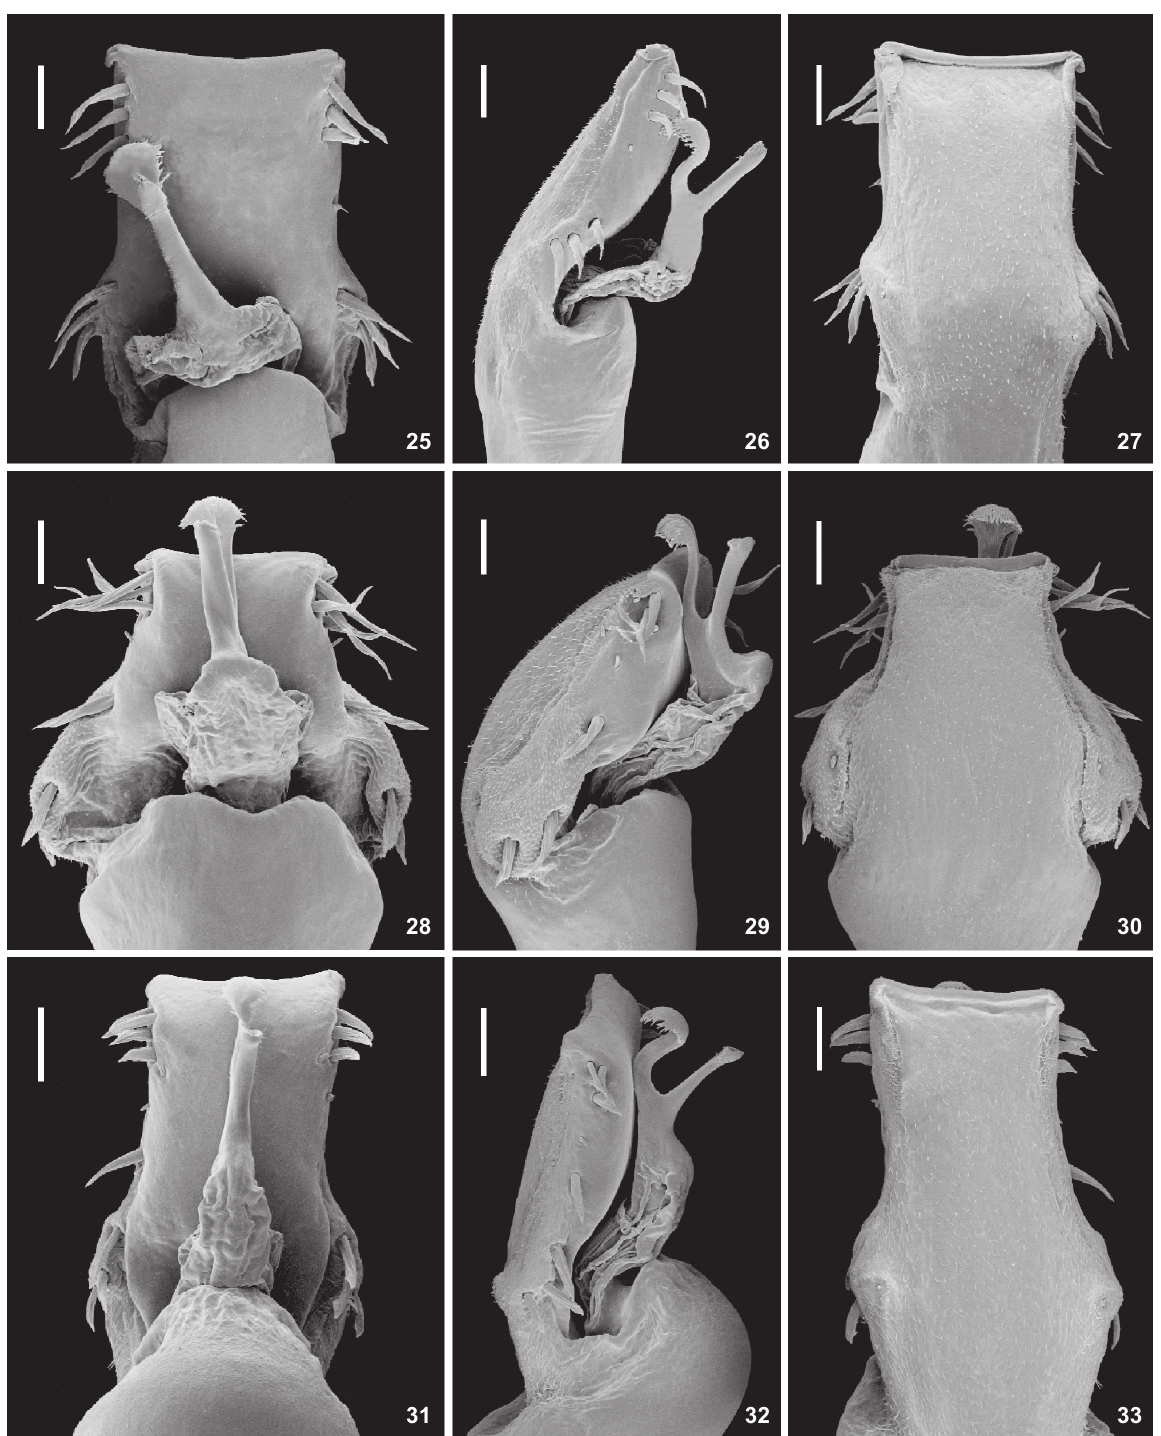
Figures 25-33. Distal part of Longiperna penis: (25-27) L. insperata (MZSP 18666); (28-30) L. kuryi sp. nov. (HS 1058); (31-33) L. trembao sp. nov. (MNRJ 05336). Scale bar = 0.05